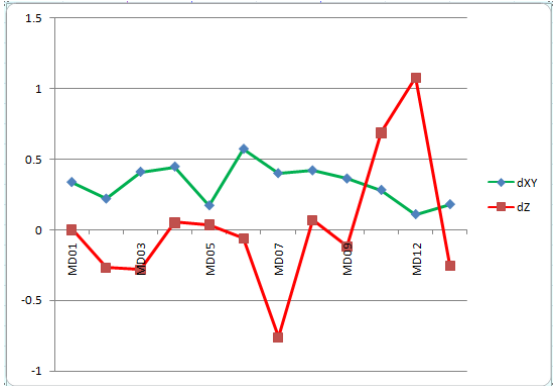
Figure 6. Graphic of ICP